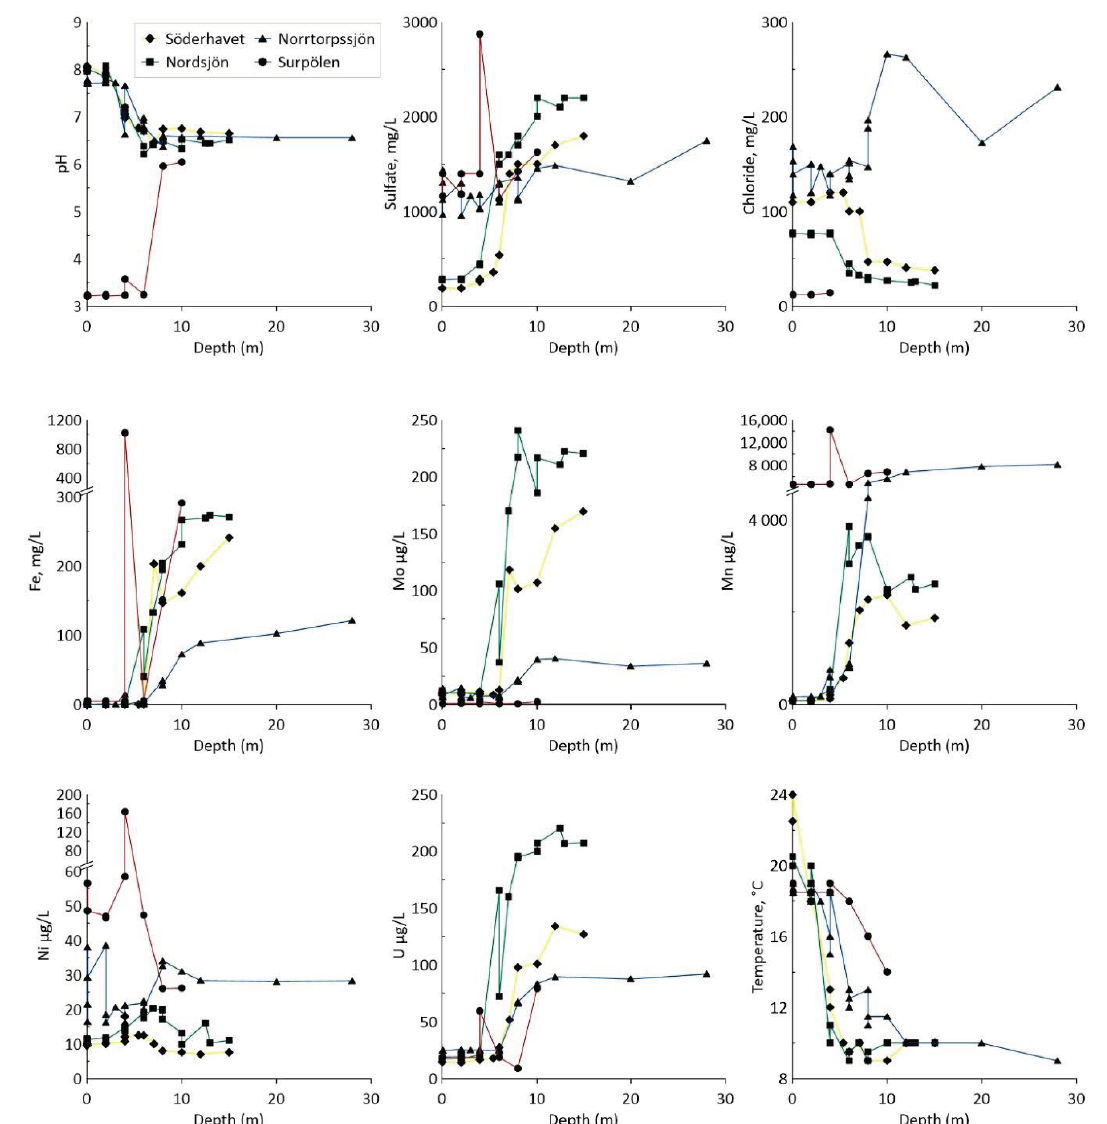
Figure 5. Depth profiles for pH, sulfate, chloride, Fe, Mo, Mn, Ni, U and temperature in pit lakes. Note changes in the y-axis for iron, manganese and nickel.